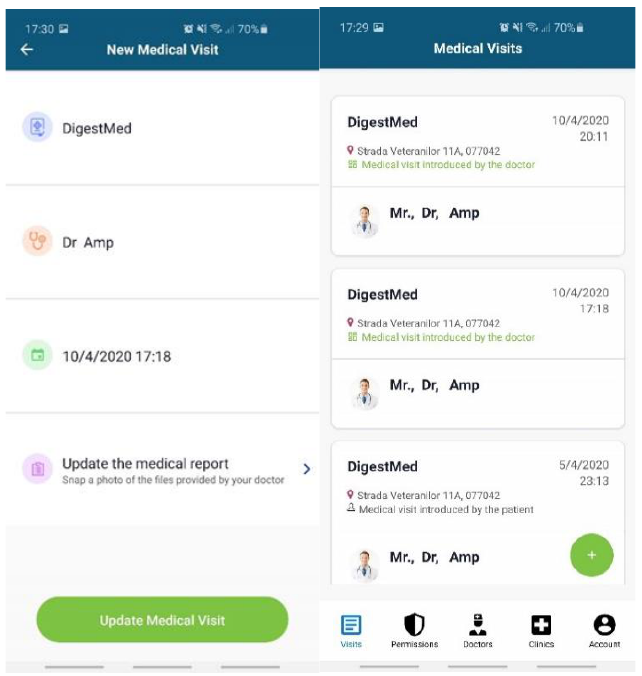
Figure 8. PatientDataChain integration with the EHR system.